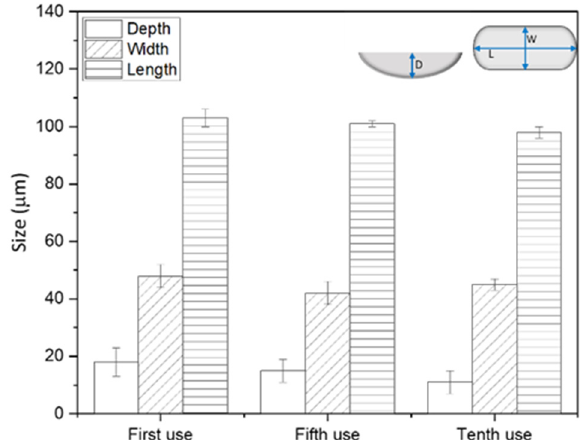
Figure 5. Average pattern feature dimensions for membranes that were patterned with the same mesh stamp up to 10 times at 65 °C and 3.55 MPa. Measurements were made using LEXT with a 20× objective. Error bars represent ±1 ơ from measurements on five pattern features.